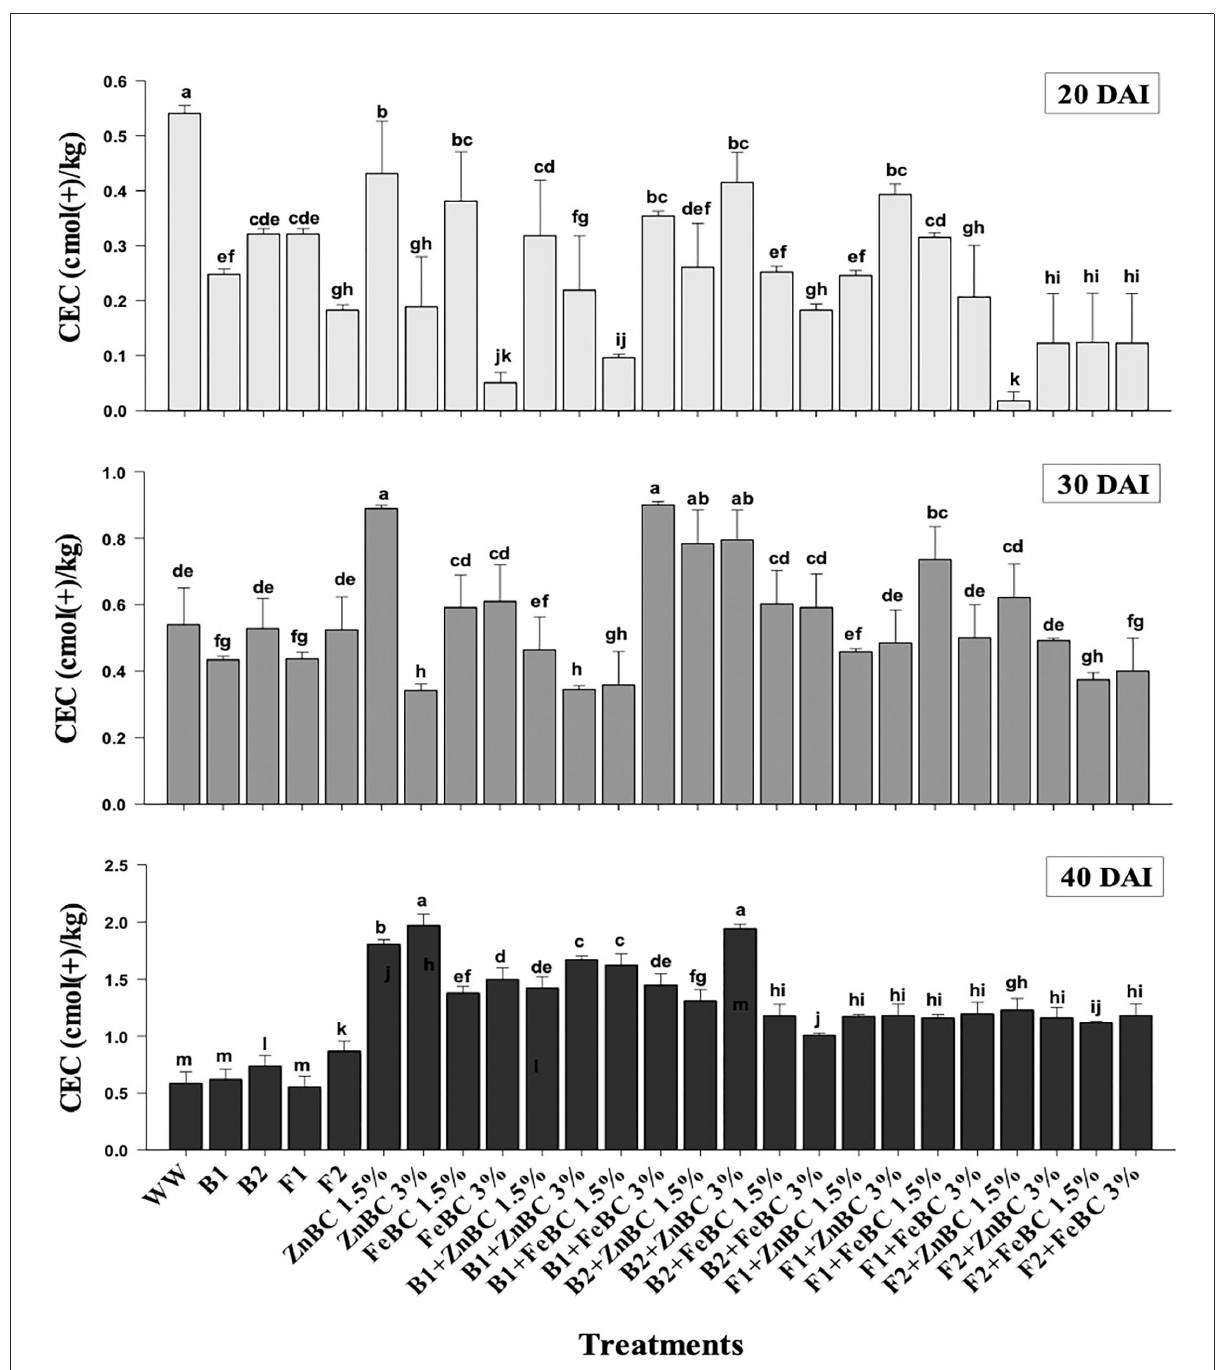
FIGURE8 Comparative analyses of CEC [cmol ( + )/kg] for treatments (Mean ± S.D) at 20, 30, and 40 DAI assessment periods.